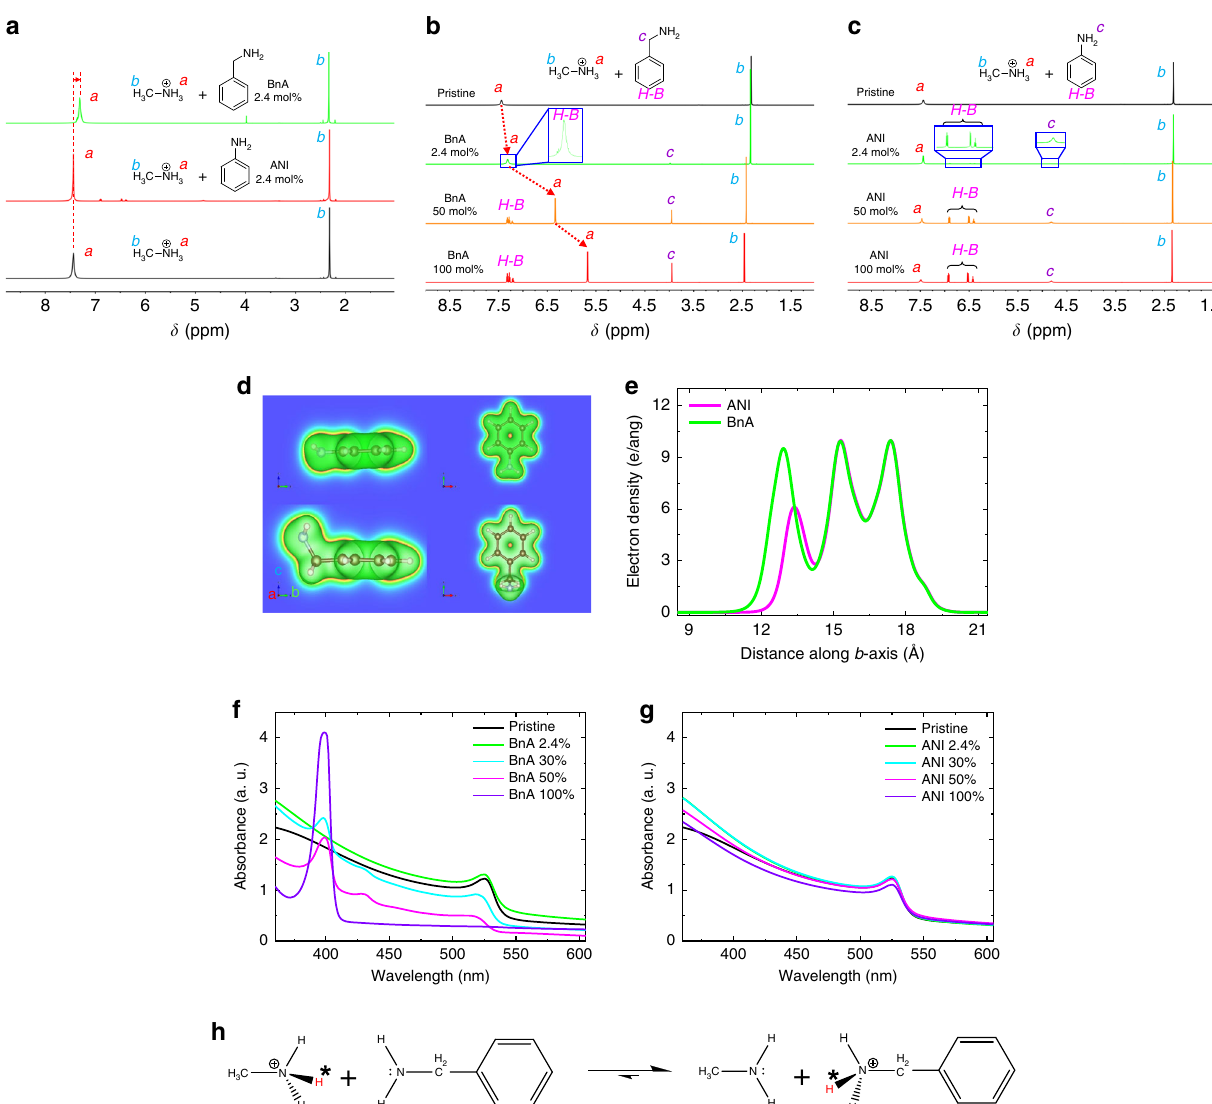
Fig. 2 Proton-transfer-induced 2D perovskite formation with BnA. a 1 H NMR spectra of MAPbBr 3 precursor solutions in DMSO- d 6 according after addition of additives. Pristine MAPbBr 3 (black), MAPbBr 3 with 2.4 mol% of ANI (black), and MAPbBr 3 with 2.4 mol% of BnA (green). b , c 1 H NMR spectra according to the different amount of BnA and ANI addition. d Electron density contour plots of BnA (bottom) and ANI (top) with an iso-surface of 0.03 e Å − 3 . e Integrated electron density pro fi le for BnA (green) and ANI (red) along with b -axis in d . f , g Absorption spectra of MAPbBr 3 thin fi lm according to the addition of BnA and ANI. h Proton-transfer reaction between MA and